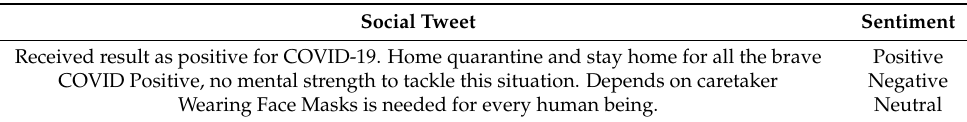
Table 1. Example for scoring the sentiment polarity by VADER.